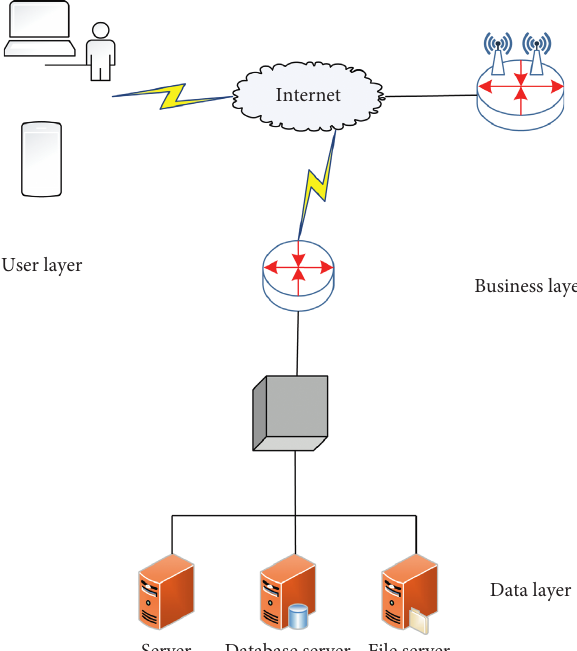
Figure 3: Framework of computer simulation system for I&P teaching.